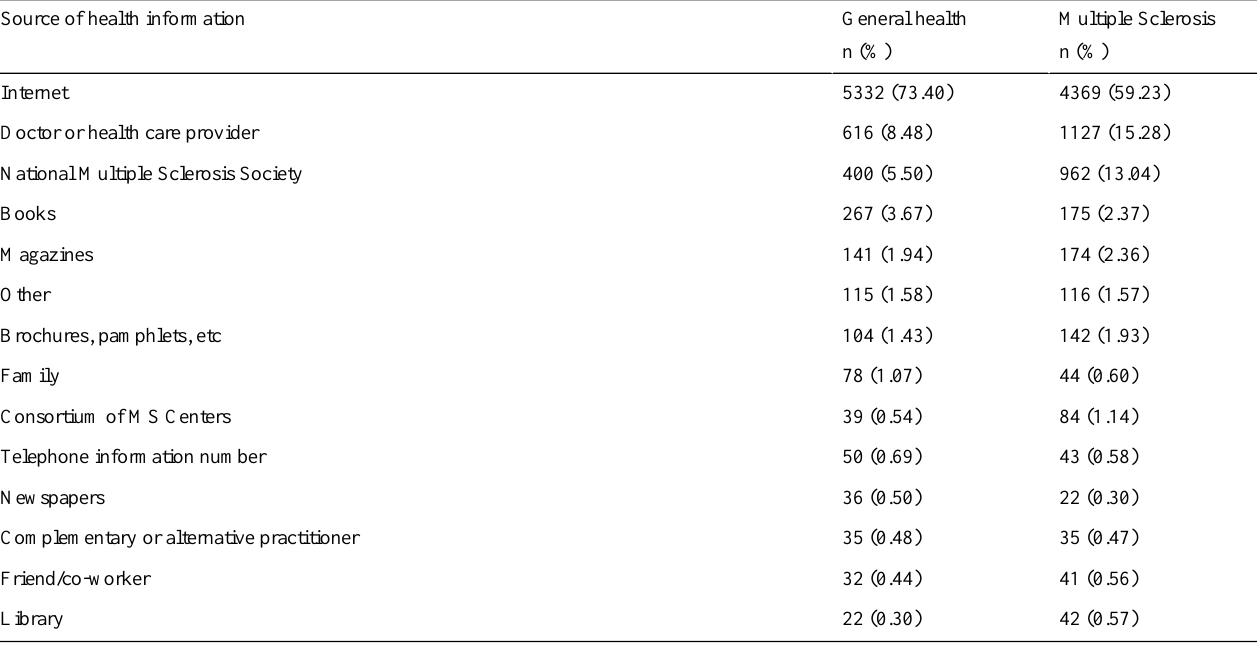
Table 2. The first source for health information, the last time it was sought (N=7376).